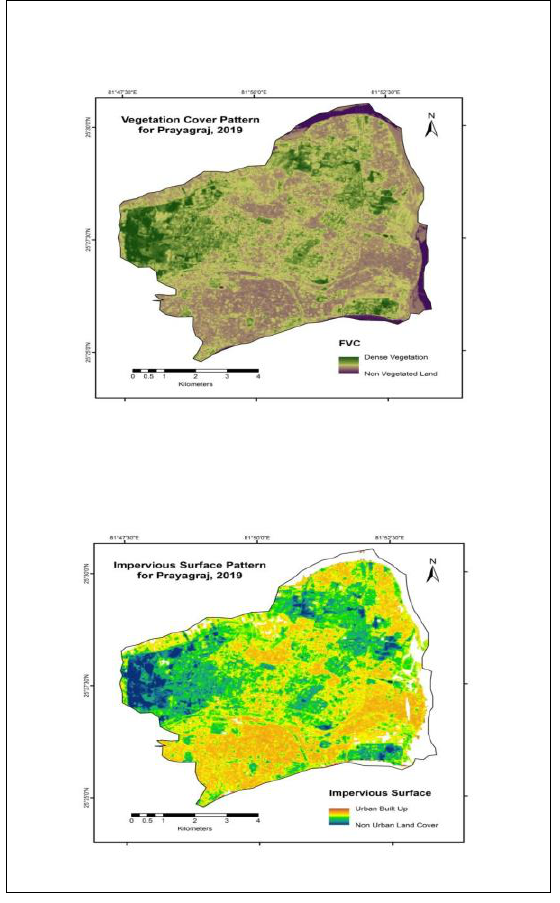
Figure 9. FVC and ISA indices for Prayagraj, 2019 The effect of built up surfaces on LST pattern were analyzed using correlation coefficients. The correlation values between the parameters are listed in Table 2. The values suggested at significance level α 0.05 , that urban sprawl was causing the rise of heat islands at certain locations. Places with dense built-up were resulting in UHI formation.